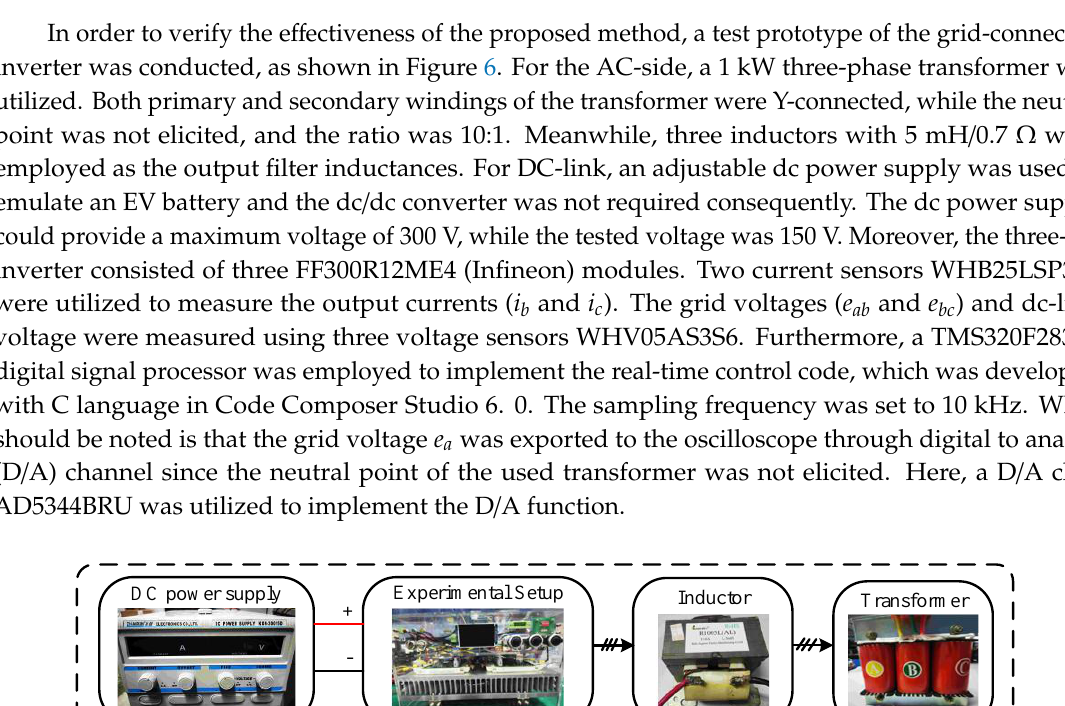
Figure 5. AV 2 R of the proposed MPC method.